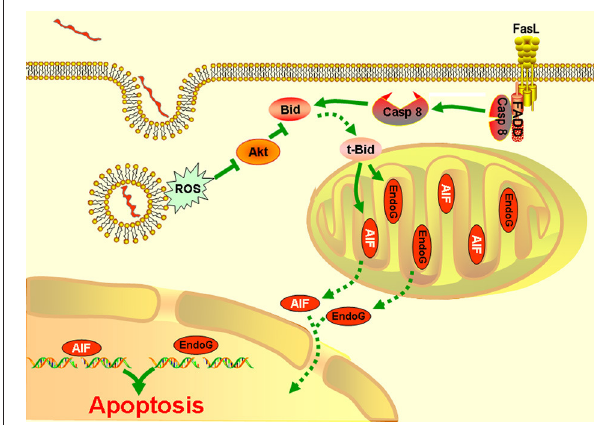
FIGURE 6 | A model of leptospire-induced apoptosis in macrophages through bid-induced release of AIF/ Endog signaling pathway. Upon contact with leptospires and during phagocytosis, macrophages generate ROS. ROS triggers the dephosphorylation of Akt. The decrease of p-Akt activated Bid to be cleaved into tBid, which reduced the mitochondrial membrane permeabilization, leading to release of AIF and EndoG. AIF and EdnoG translocated into the nuclear and caused the DNA fragmentation and apoptosis. In parallel, infection induced the activation of caspase-8 through Fas/FasL-FADD pathway. Caspase-8 also cleaved the Bid into tBid, which caused the release and nuclear translocation of AIF and EndoG, and induced the apoptosis. The green solid line: stimulatory or inhibitory modification; the green dotted line: